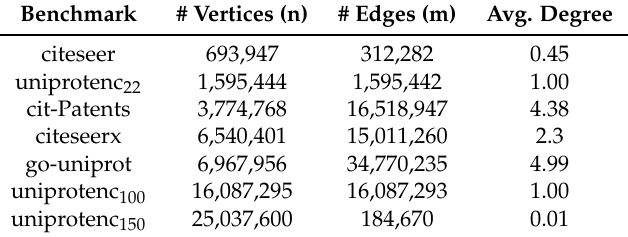
Table 1. The large benchmark graph set.